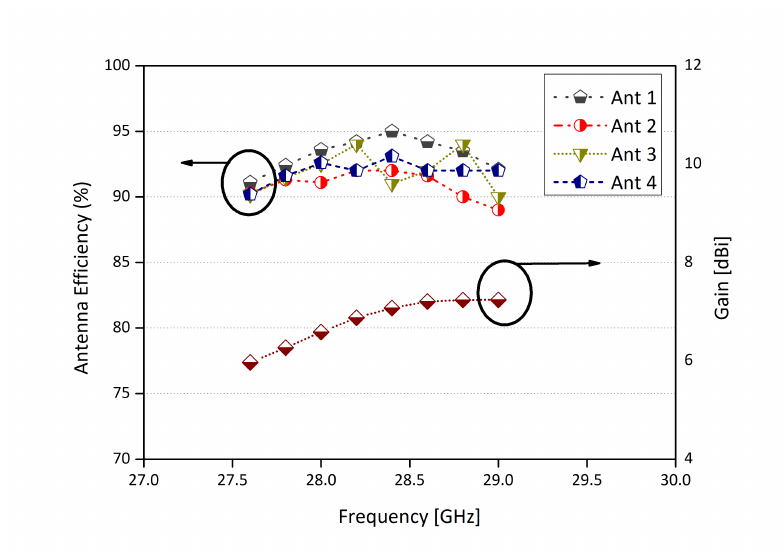
Figure 7. Antenna Efficiency and Simulated Gain of MIMO